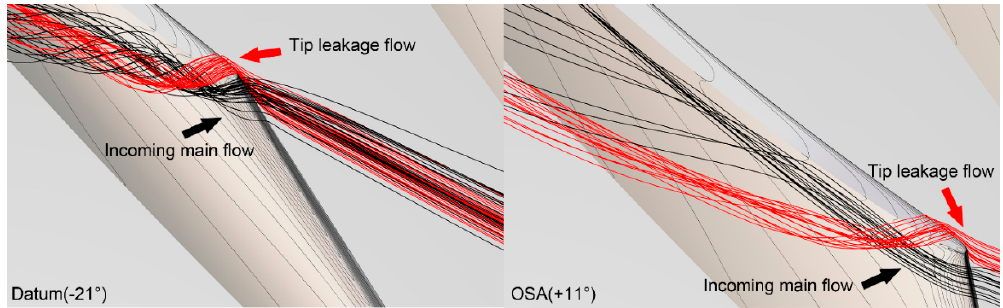
Figure 21. 3D tip streamlines and static pressure isolines on splitter II.